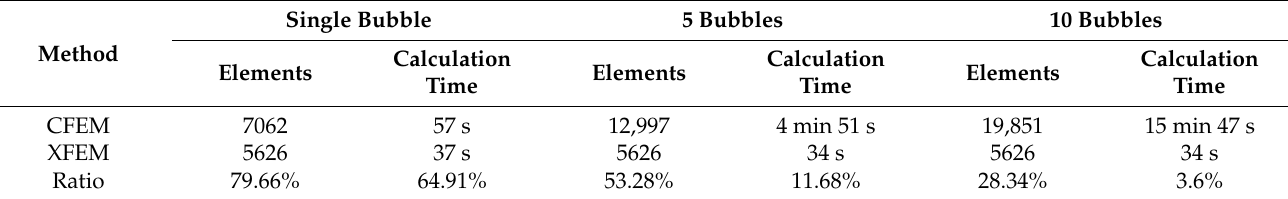
Table 9. Contrast of calculation saving and